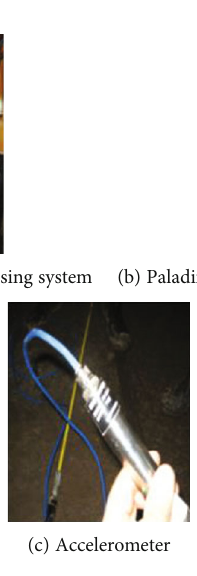
Figure 12: Microseismic monitoring system composition.